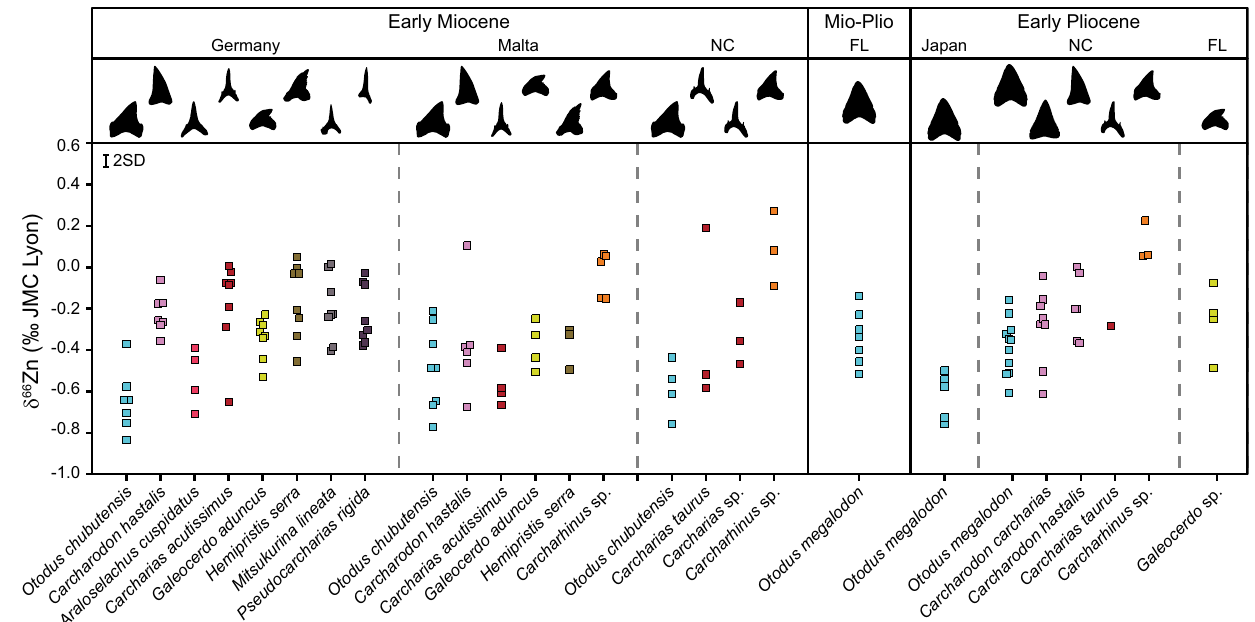
Fig. 2 Zinc isotope ( δ 66 Zn) composition of fossil elasmobranch enameloid. Teeth are from the Early Pliocene of Japan, North Carolina (NC) and Florida (FL), Pliocene to Miocene transition of Florida, the Early Miocene of North Carolina, Germany and Malta. For more details on the sample background, see Supplementary Data 1, Supplementary Note 2. Silhouettes are not to scale. Measurement uncertainty is indicated at the 2 SD level. Samples are colour- coded following their genus, regardless of locality. Source data are provided as a Source Data fi le.